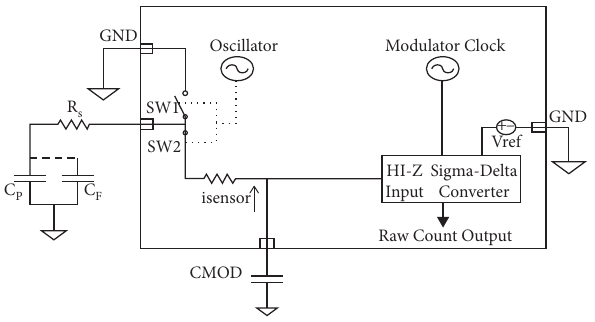
Figure 2: CapSense block